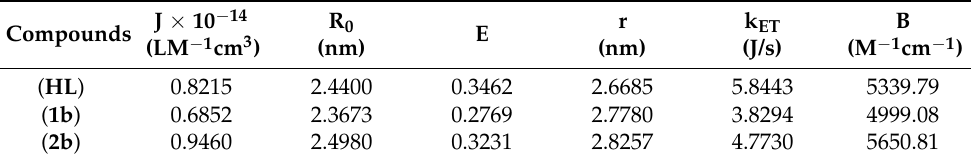
Table 5. Fluorescence Resonance Energy Transfer (FRET) parameters for Donor (BSA)–Acceptor (compound)